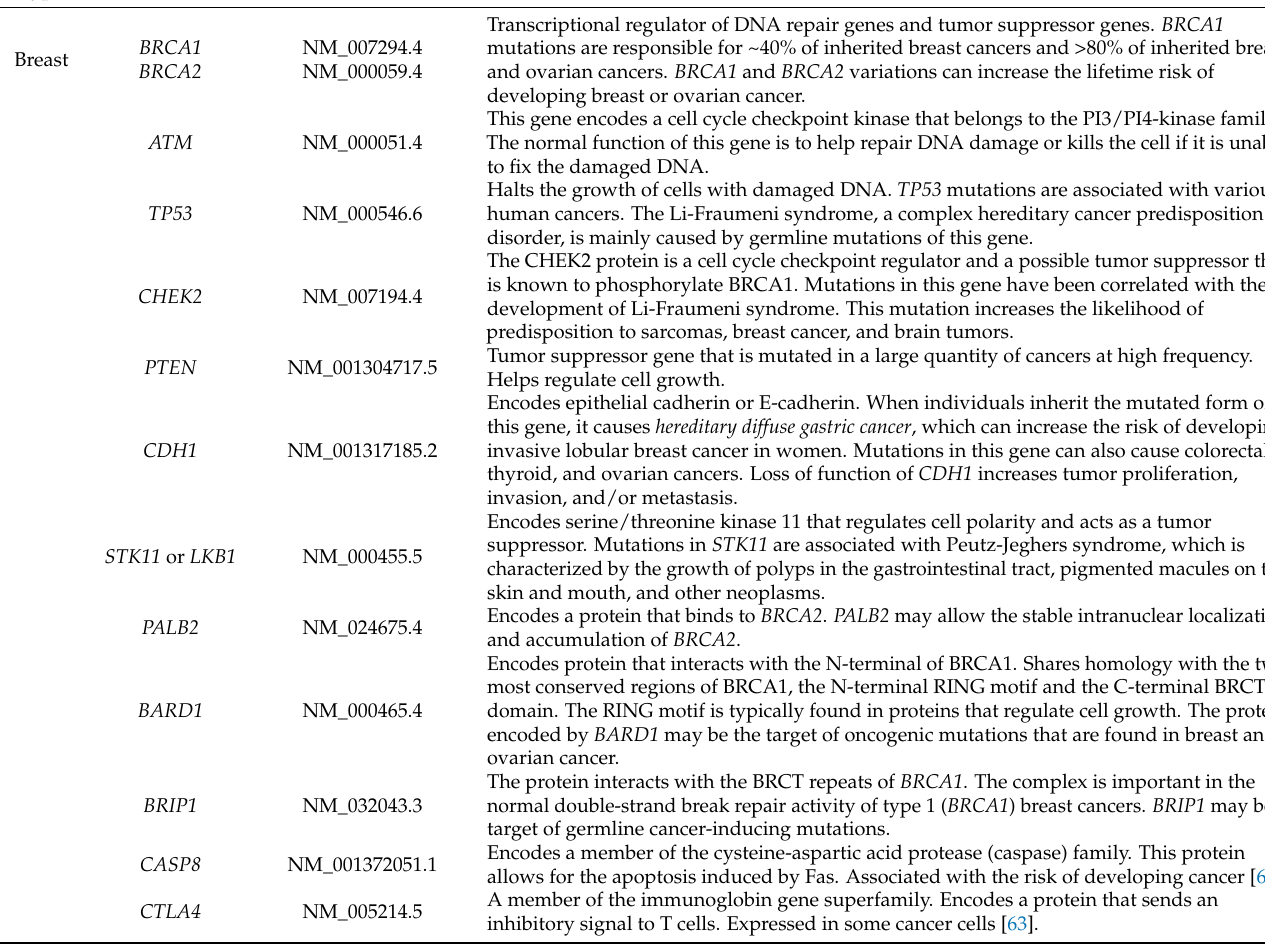
Table 1. Representative genes responsible for breast cancer and found in